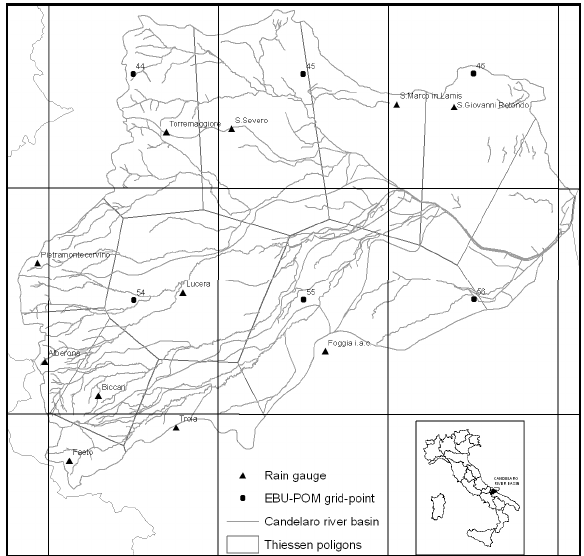
Figure 1 . The rainfall network of the Candelaro river basin and the corresponding RCM grid-cells.